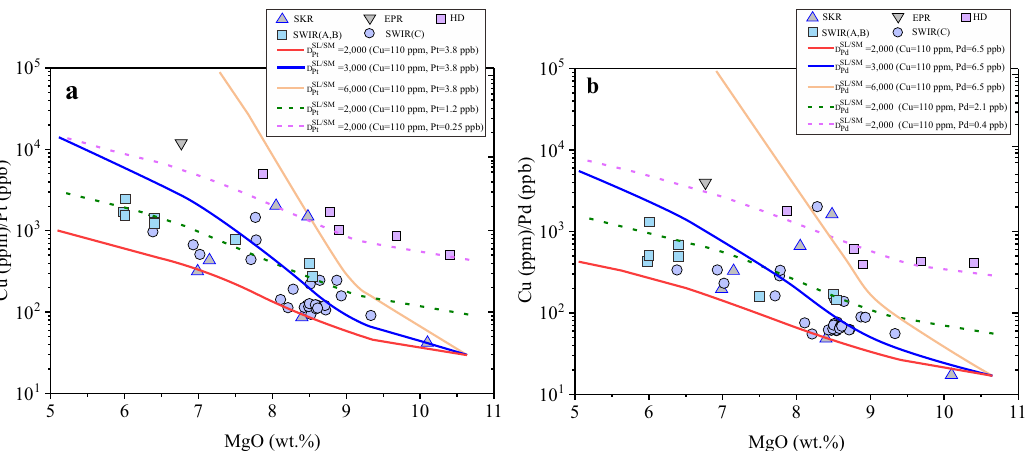
Fig. 5 Modeled Cu/Pt and Cu/Pd ratios as a function of the MgO content during MORB differentiation. a, b The D SL = SM Pt ; Pd values of 2000 – 6000 were applied in the modeled differentiation trends, and the observed Cu/Pt and Cu/Pd ratios in MORB can be largely explained. Note that the solid and dashed differentiation lines were modeled using different initial Pt and Pd contents (see main text for details). The MORB Cu, Pt, and Pd data were taken from refs. 5, 43 . SKR Southern Kolbeinsey Ridge, EPR East Paci fi c Rise; SWIR (A, B): Southwest Indian Ridge Zone A and B; SWIR(C): Southwest Indian Ridge Zone C, HD: HREE-depleted MORBs. Source data are provided in Supplementary Data